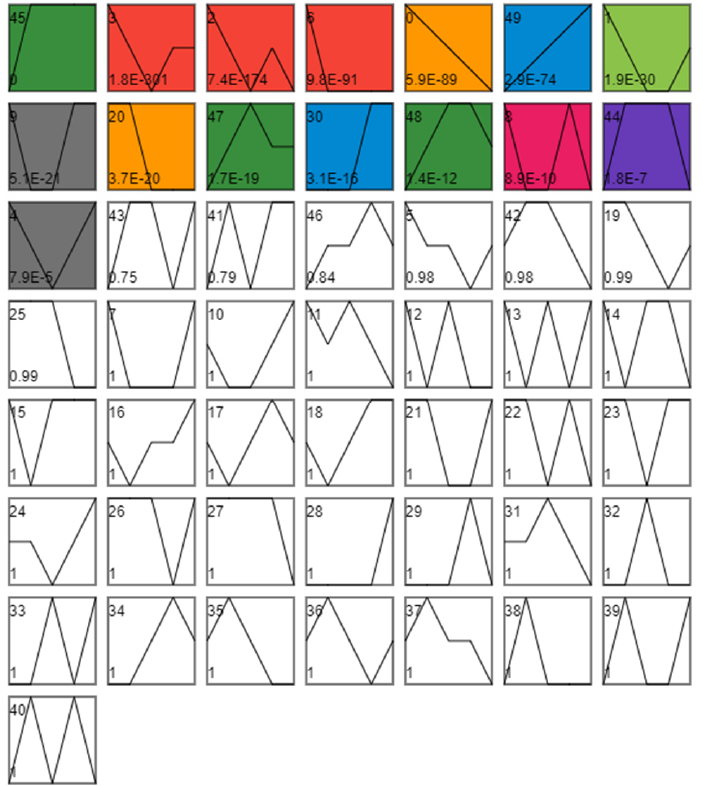
Figure 4. Time series analysis. Each profile corresponds to a rectangle. The number in the upper left corner of the rectangle is the number of the profile, starting from 0, where the broken line is the trend of the expression amount changing over time, and the value in the lower-left corner is its corresponding significance level p -value. Trend diagram with color: it indicates that the time-series pattern of the profile conforms to the significant change trend. Profiles with the same color belong to the same cluster (profiles with similar trends belong to the same category—the same color). Figure shows that all DEGs can be divided into 50 profiles according to their expression trends, among which 15 categories have significant gene expression trend changes. Additionally, these 15 profiles with significant expression trend changes were further divided into eight clusters because of similar expression trends (consistent color indicates similar expression